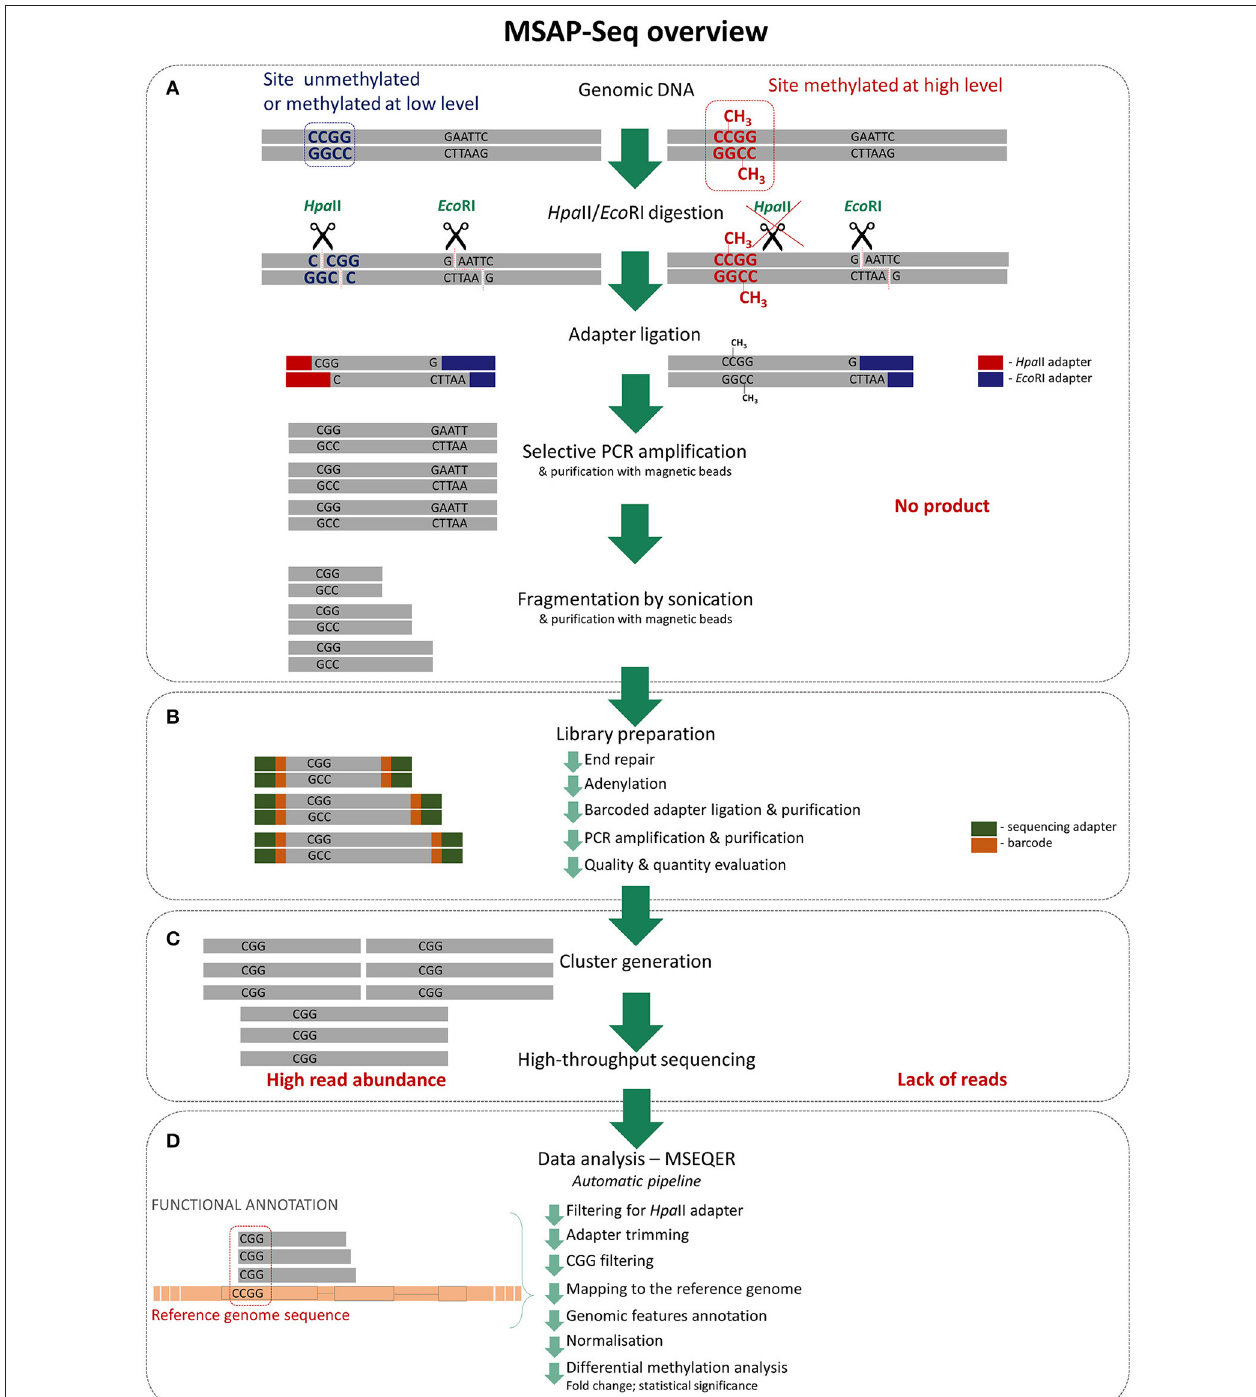
FIGURE 1 | Detailed MSAP-Seq assay overview (A) Genomic DNA is cleaved using rare cutter ( Eco RI) and methylation sensitive restriction enzyme ( Hpa II); only unmethylated recognition sites are digested by Hpa II. Then adapters specific to sticky ends are ligated and obtained fragments are amplified in PCR using selective primers; only fragments generated from unmethylated regions are amplified as they contain ends complementary to adapters. Products are then purified and fragmented by sonication to create shorter tags. (B) Purified fragments are used for standard library preparation involving following steps: end repair, adenylation, barcoded adapters ligation and purification, PCR amplification and purification. Then libraries quality and quantity is estimated. (C) Prepared libraries are pooled and processed thru cluster generation and high-throughput sequencing. (D) Sequencing data are analyzed using dedicated automatic pipeline—MSEQER. Firstly, reads are filtered for presence of Hpa II adapter and adapters are clipped. Then only reads containing CGG tags on the ends are mapped to the reference genome and functionally annotated. Obtained counts at each of the CCGG sites are normalized and differential methylation analysis among sets of samples is performed.